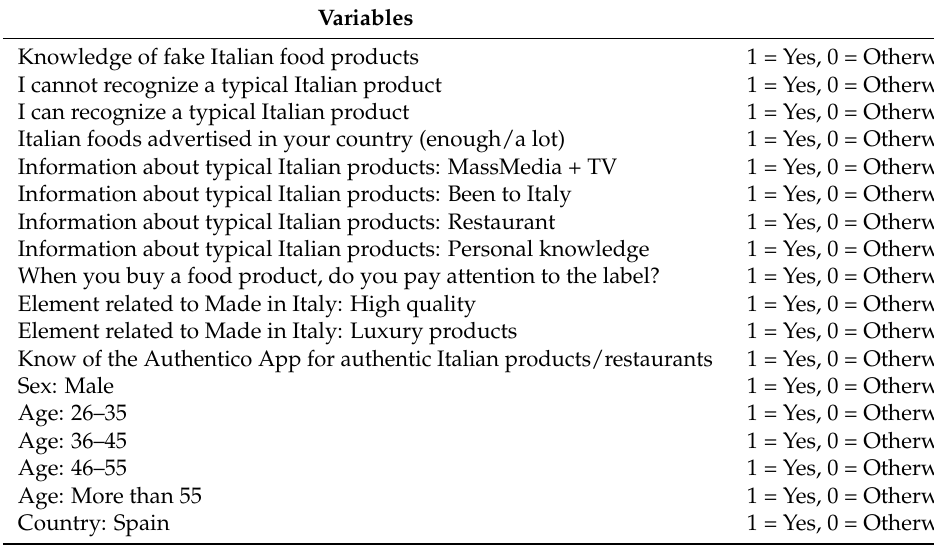
Table 1. Definition of